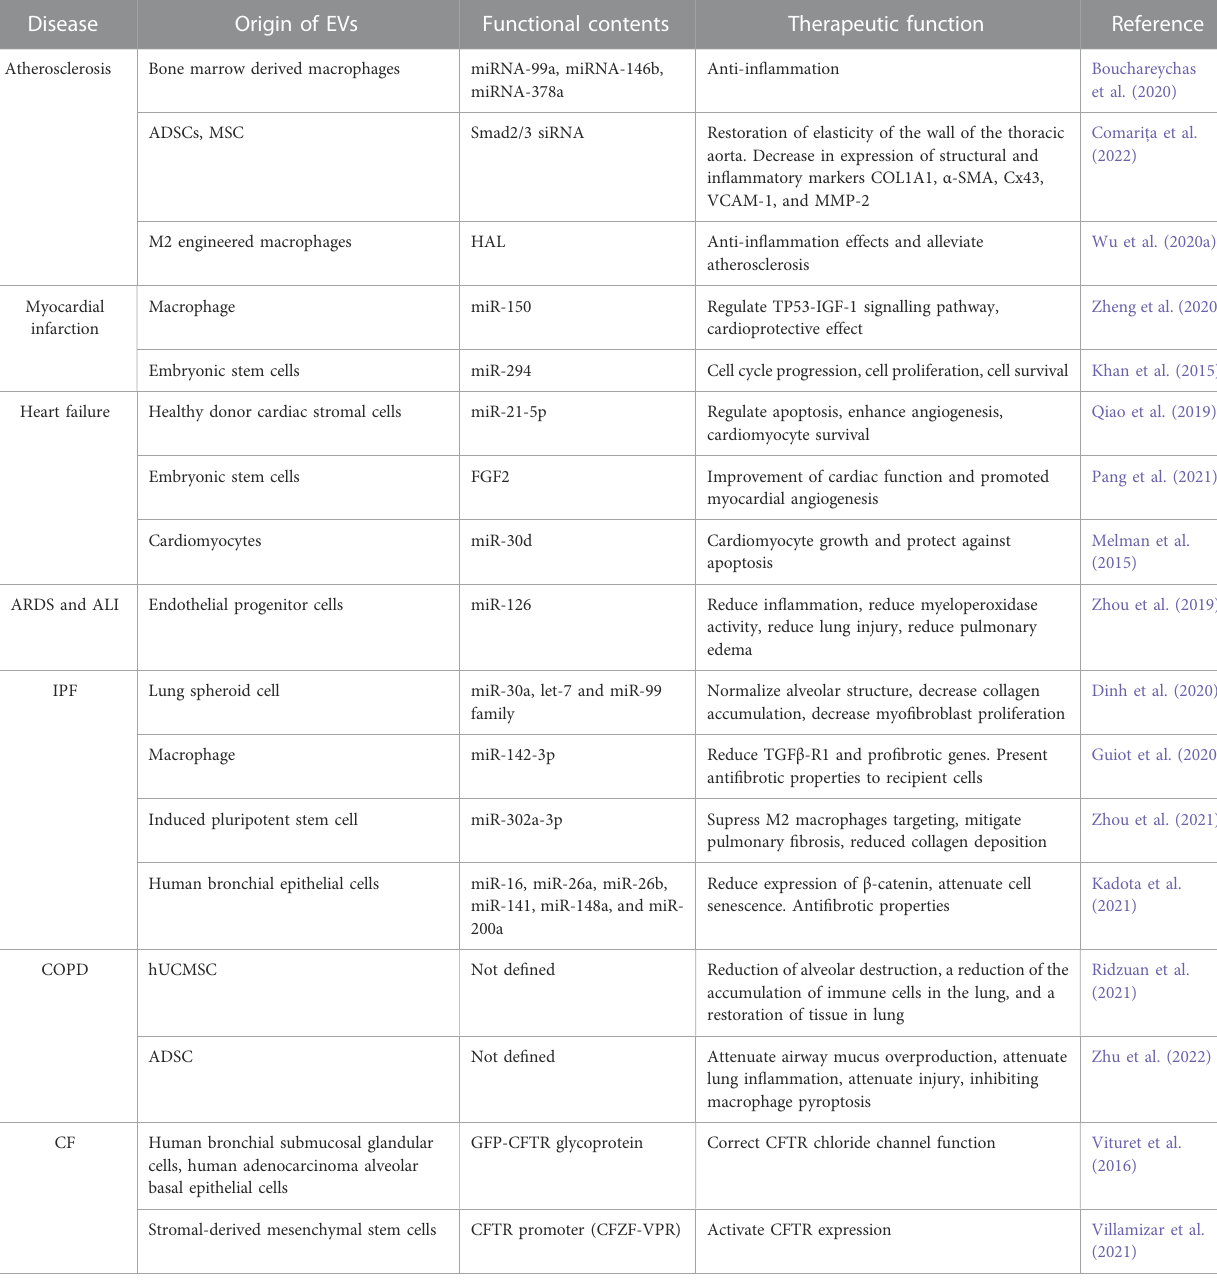
TABLE 1 Extracellular vesicles-based therapeutic in cardiopulmonary disease.